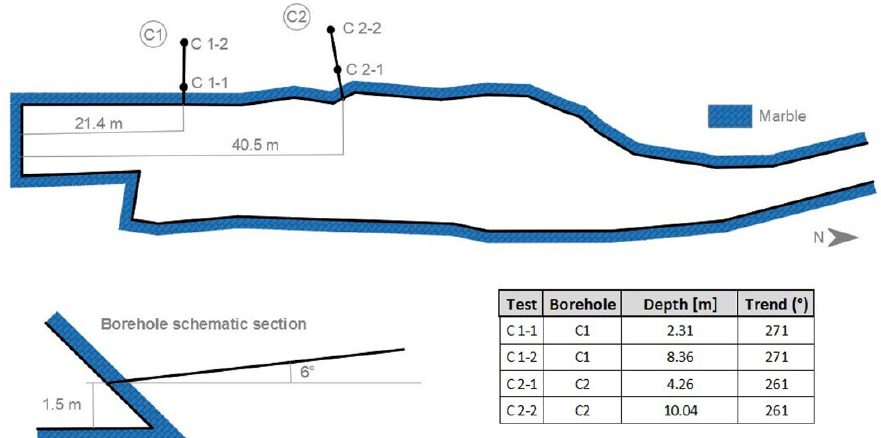
Figure 7. Planimetric view of the Sottovettolina quarry, location of the in situ stress measurements (C 1-1, C 1-2, C 2-1, and C 2-2), and exemplificative schematic section aimed at showing the borehole dip. The table on the right resumes the geometry of the tests.